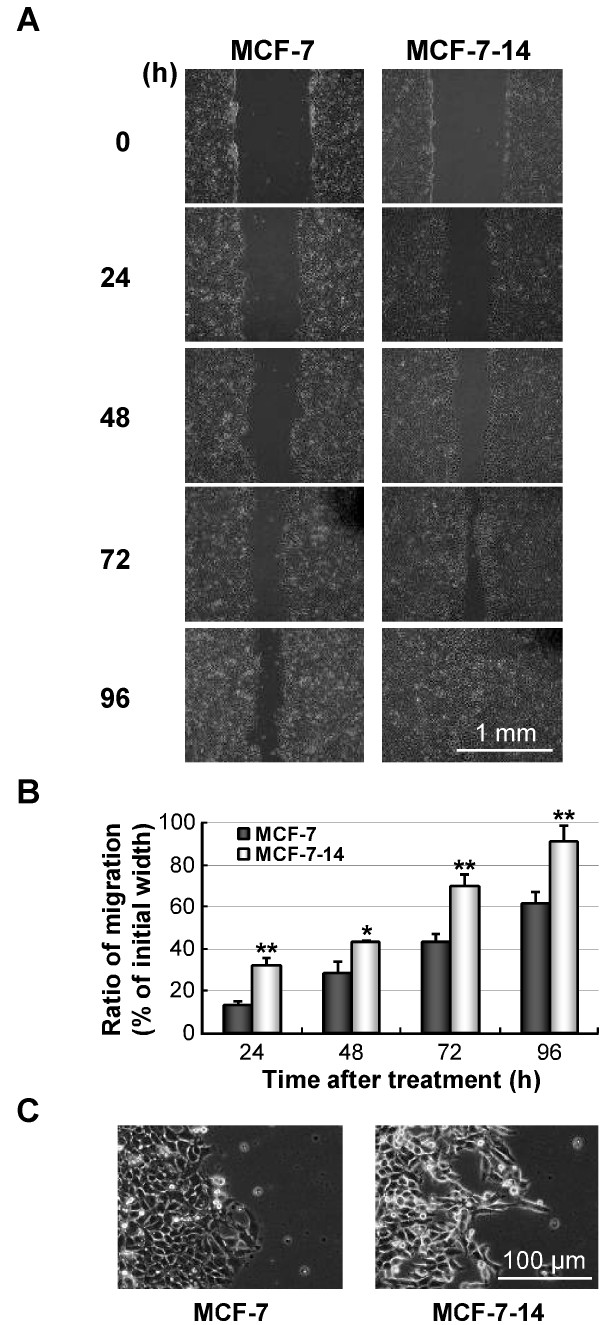
Migratory abilities of MCF-7 and MCF-7-14 cells in wound healing assay. (A) Optical microscopic images of in vitro wound healing at 0, 24, 48, 72 and 96 h after the creation of wounds. (B) Comparison of images to quantify the migration rate of the cells. Wound distances were measured at each time point and expressed as percent wound closure by comparing the zero time. Data are the means ± SD (n = 3). Statistical analysis was performed by Student's t test. *, P < 0.05; P < 0.01, compared with MCF-7. (C) Optical microscopic images of MCF-7 and MCF-7-14 cells at the invading edges of the wound at 48 h after the creation of wounds.